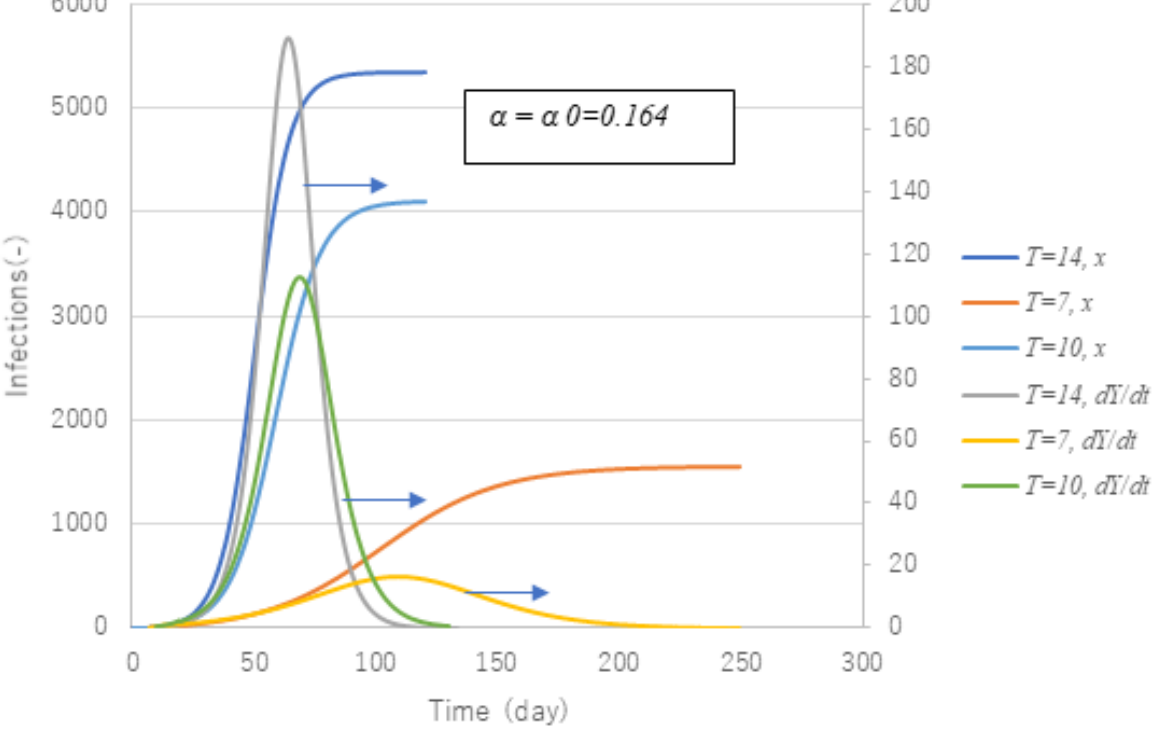
Figure 12. Effect of time lag T from infection until hospitalization on cumulative infections x (left axis) and daily new confirmed cases dY/dt (right axis). The reduction of T has a significant effect on both x and dY/dt